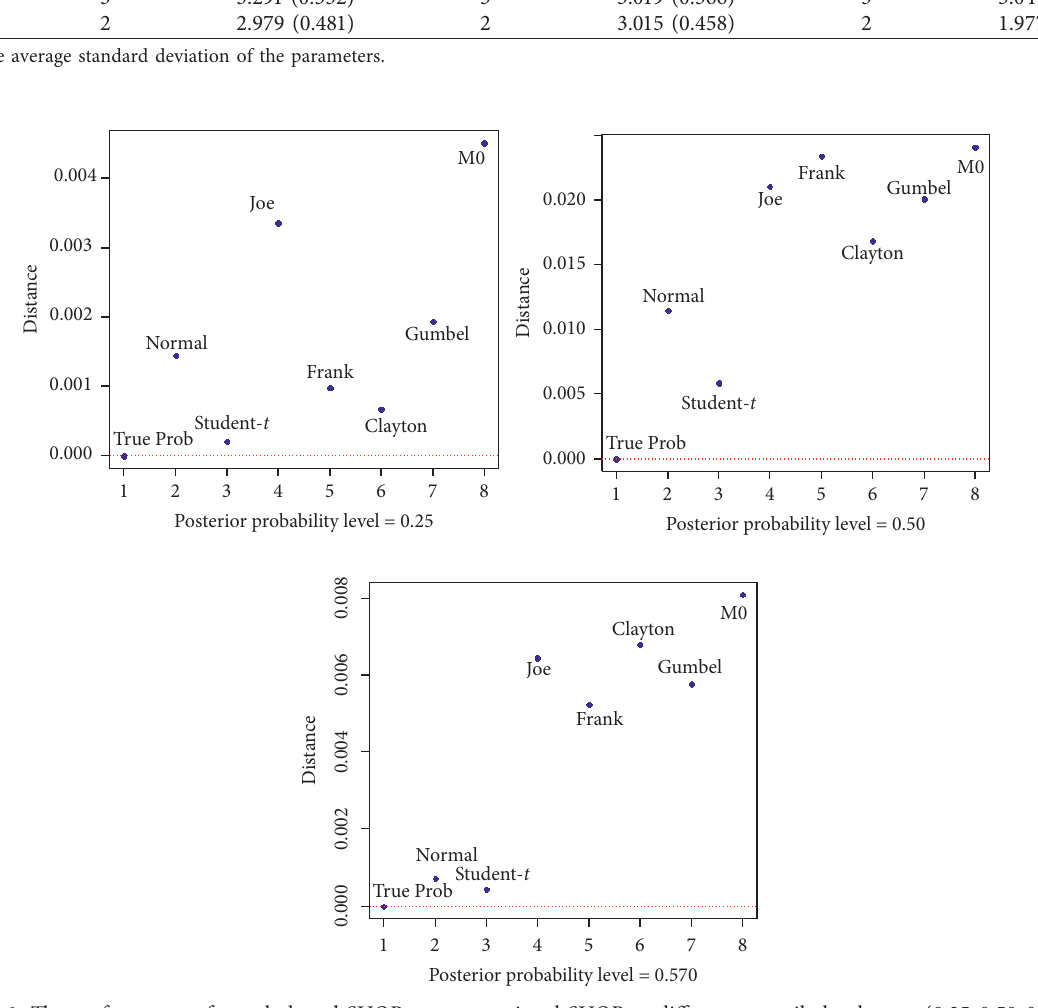
Figure 1: The performance of copula-based SUQR vs. conventional SUQR at different quantile levels, α � ( 0 . 25 , 0 . 50 , 0 . 75 ) .